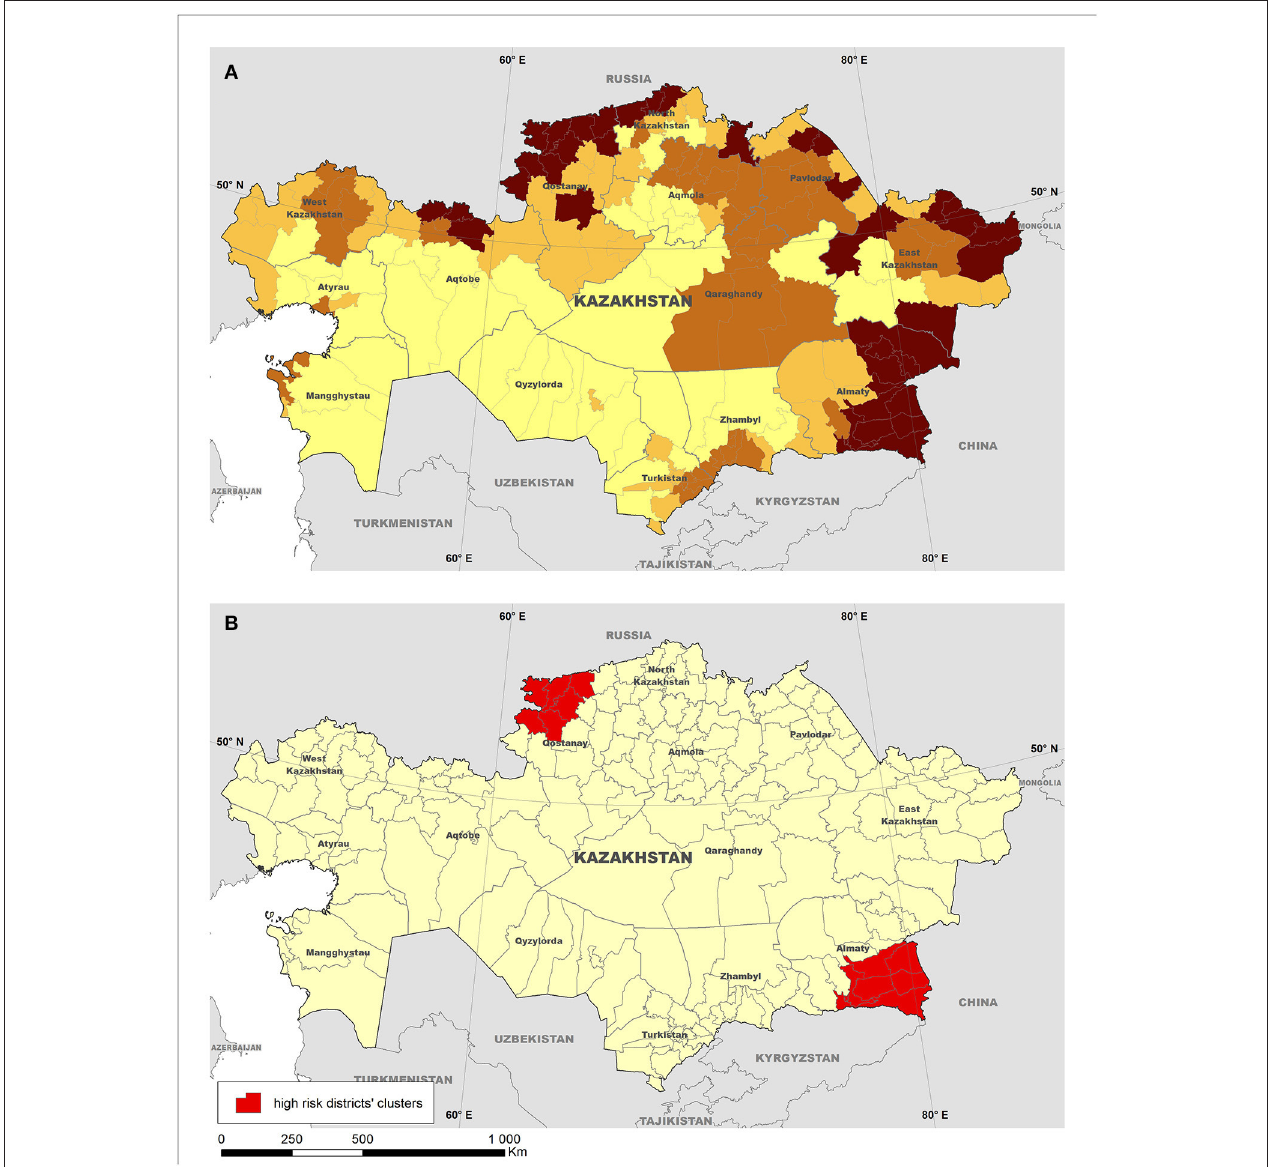
FIGURE 3 | Risk for introduction of African swine fever (ASF) into Kazakhstan estimated using a conjoint analysis model. The map on the top (A) depicts districts grouped into four quantiles based on the predicted risk (the darker the shade, the higher the risk), whereas the map on the bottom (B) illustrates the location of clusters of high risk for the introduction of ASF into the country detected using the normal model of the spatial scan